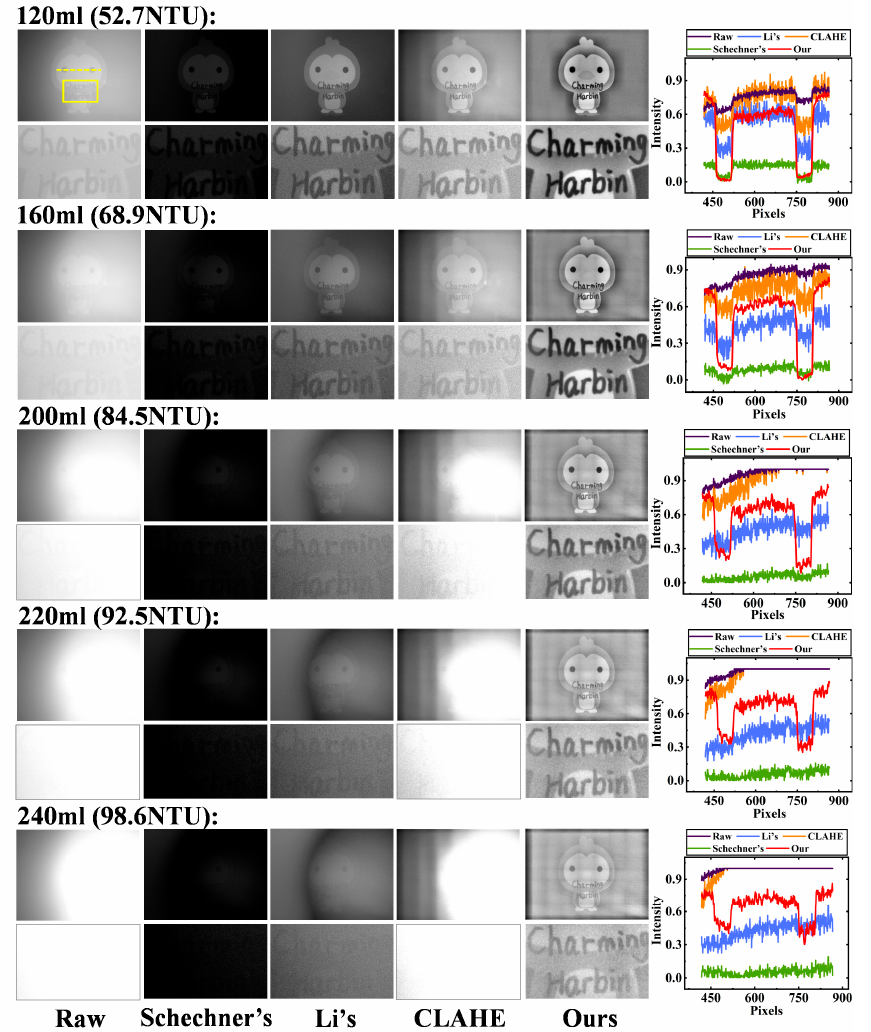
Figure 9. The first column is the raw image intensity; the second column is the processing result of Schechner’s method [6]; the third column is the processing result of Li’s method [25]; the fourth column is the CLAHE processing result [11]; and the fifth column is ours; the sixth column compares the pixel grayscale indexing results of the raw image intensity and the different methods (along the yellow dashed